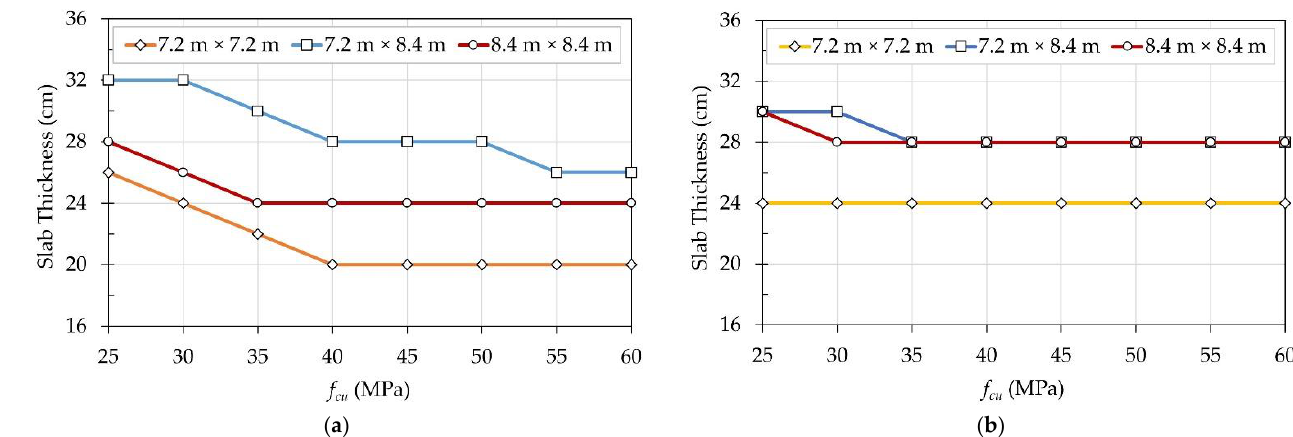
Figure 14. Effects of slab thickness on the optimal cost: ( a ) FSWD; ( b ) FP.